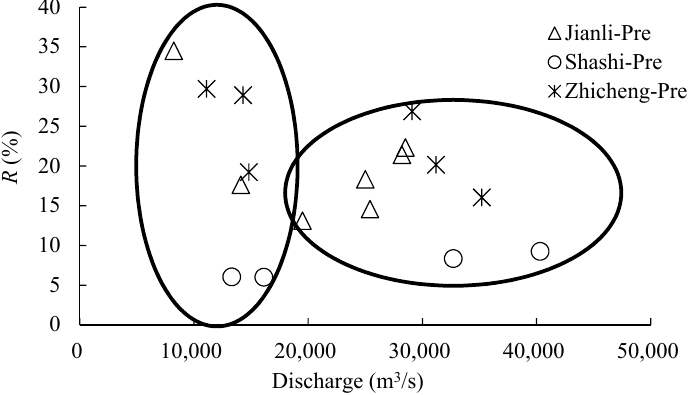
Figure 14. Deviation ratio of sediment transport rate by data measured before TGD dam operation.